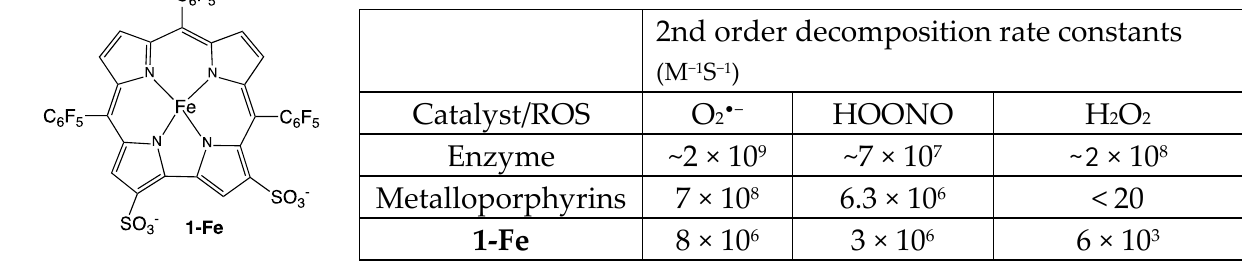
Scheme 1. The structure of the corrole-based catalytic antioxidant 1-Fe and a comparison of its ROS decomposition rates relative to those of the natural enzymes (SOD for O 2 •− and catalase for H 2 O 2 ) and porphyrin-based metal (Mn or Fe) complexes.[28 – 31].